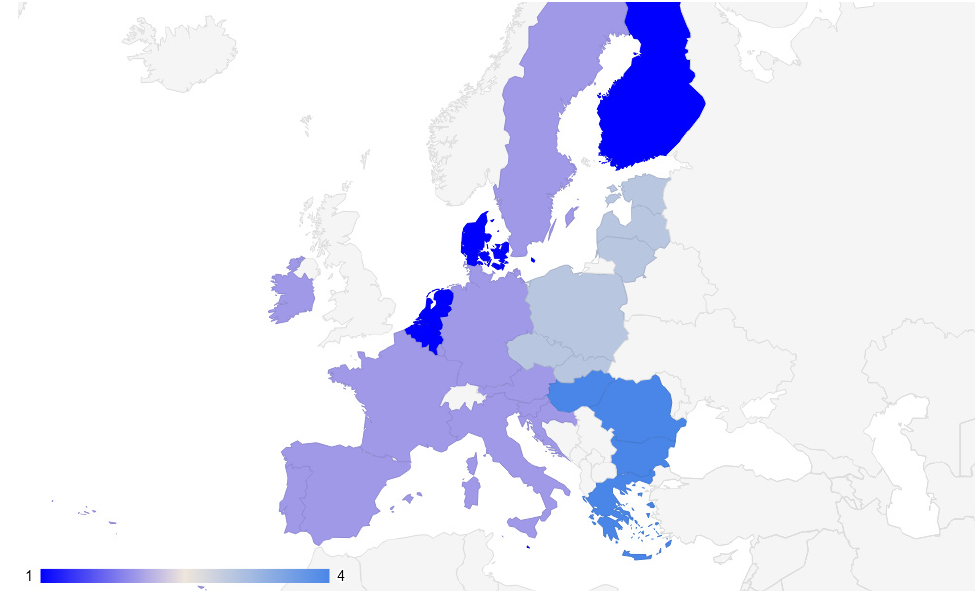
Figure 8. The level of the EU countries in terms of digital maturity of SMEs (own elaboration).